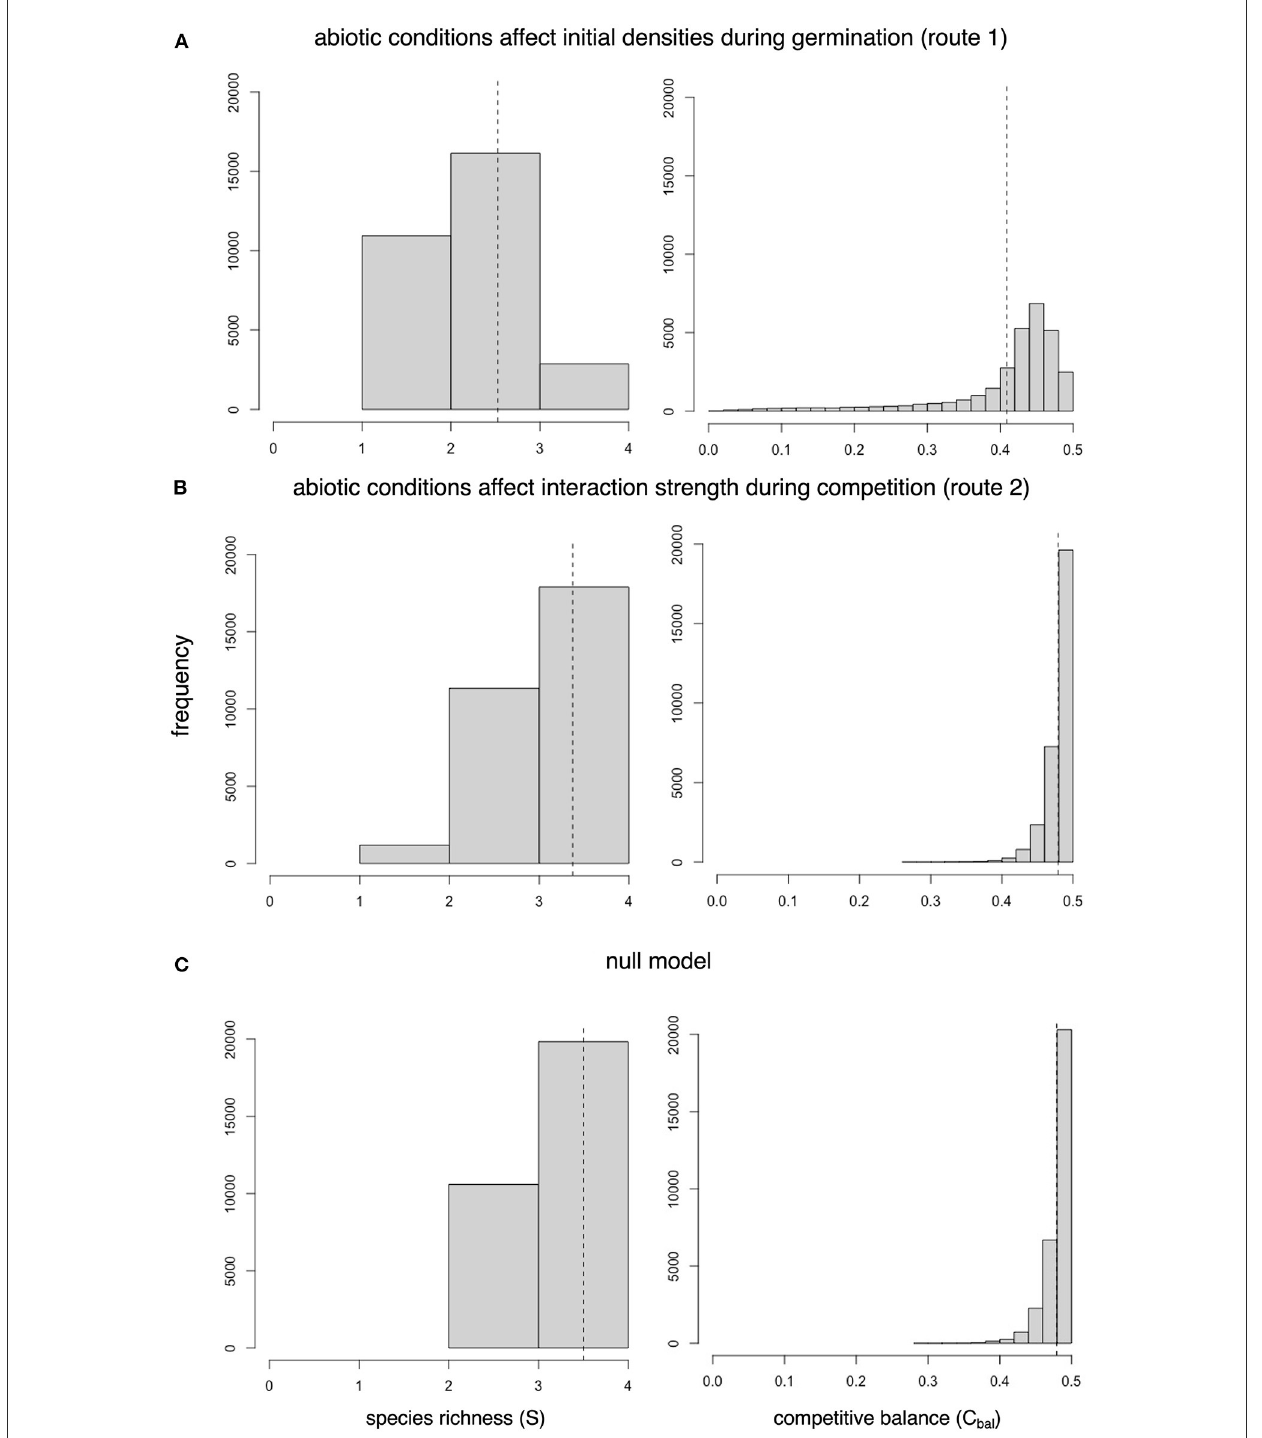
FIGURE3 Histograms of species richness and competitive balance measured in small sampling units (5 x 5 microsites) across all parameter combinations from (A) simulations of abiotic effects on initial densities during germination (route 1), (B) simulations of abiotic effects on interaction strengths during competition (route 2), and (C) null model simulations when germination and competition were insensitive to changes in abiotic conditions. Dashed lines show mean values.